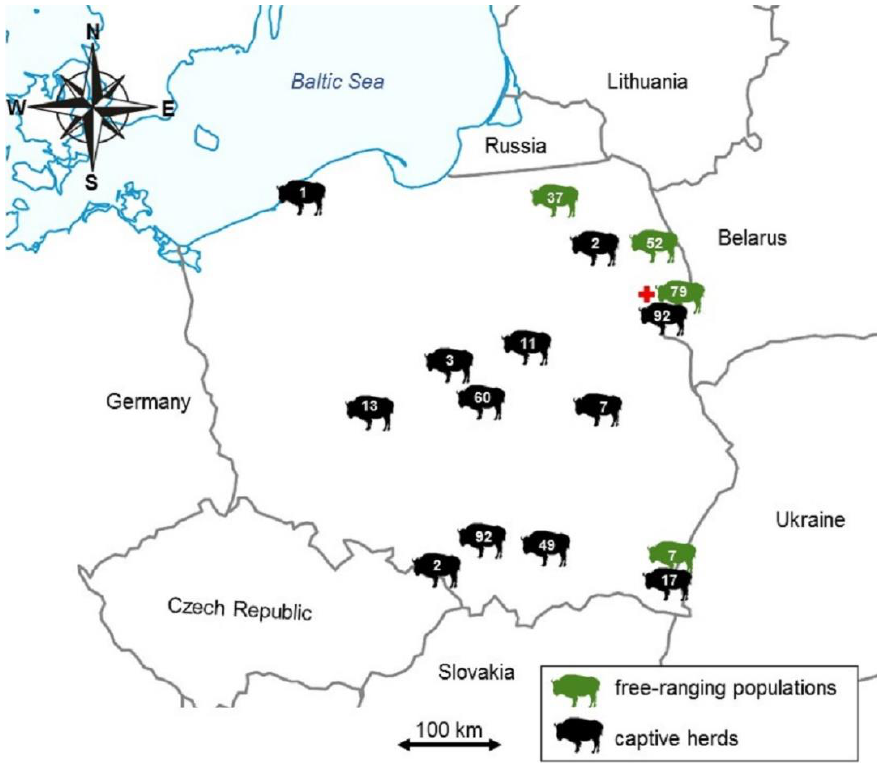
Figure 1. The map of Poland showing the numbers of European bison divided into free-ranging populations (green) and captive herds (black). The red cross indicates the location of single seropositive, 6-year-old male from wild population of Białowieska Forest.